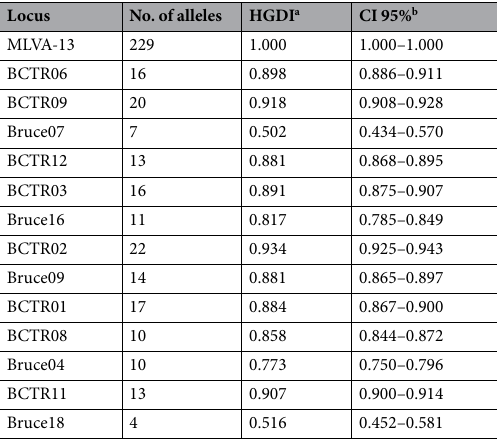
Cluster analysis and geographical and temporal distributions of B . canis strains. A cluster anal- ysis of the MLVA allele profiles of the 229 B . canis isolates with nine reference sequences by BioNumerics gen- erated three large clusters, Cluster A, Cluster B and Cluster C, as well as 3 sub-clusters, C1, C2 and C3 (Fig. 1). Distribution the 229 isolates in different states is shown in Fig. 2. Cluster A mainly contained isolates from Oklahoma in 2010 (8/9) and 2011 (22/32), as well as all the isolates from Iowa in 2013 (6/6). Cluster B mainly consisted of isolates from Indiana (19/25) and Ohio in 2013 (18/33), as well as from Ohio in 2012 (6/8). Most